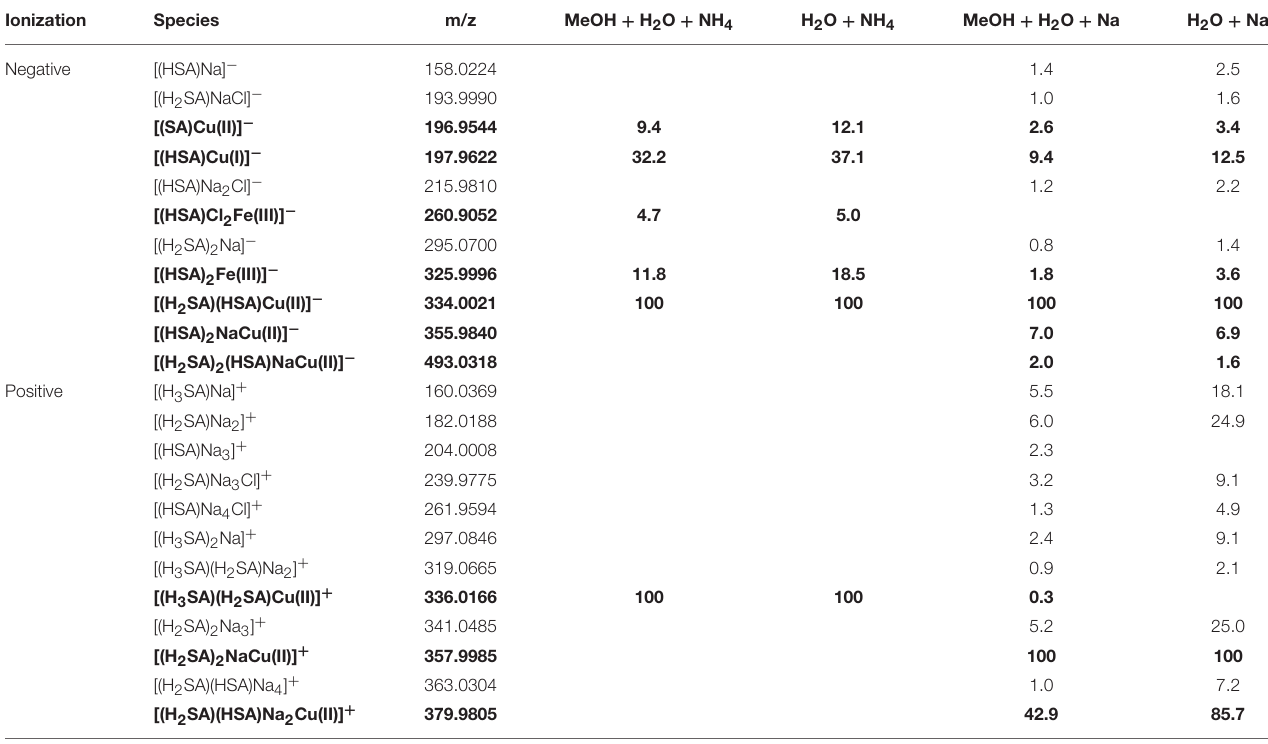
TABLE 5 | Detected SA and SA ± Fe ± Cu species (bold) in the four analytical setups in FT-ICR-MS. Ionization